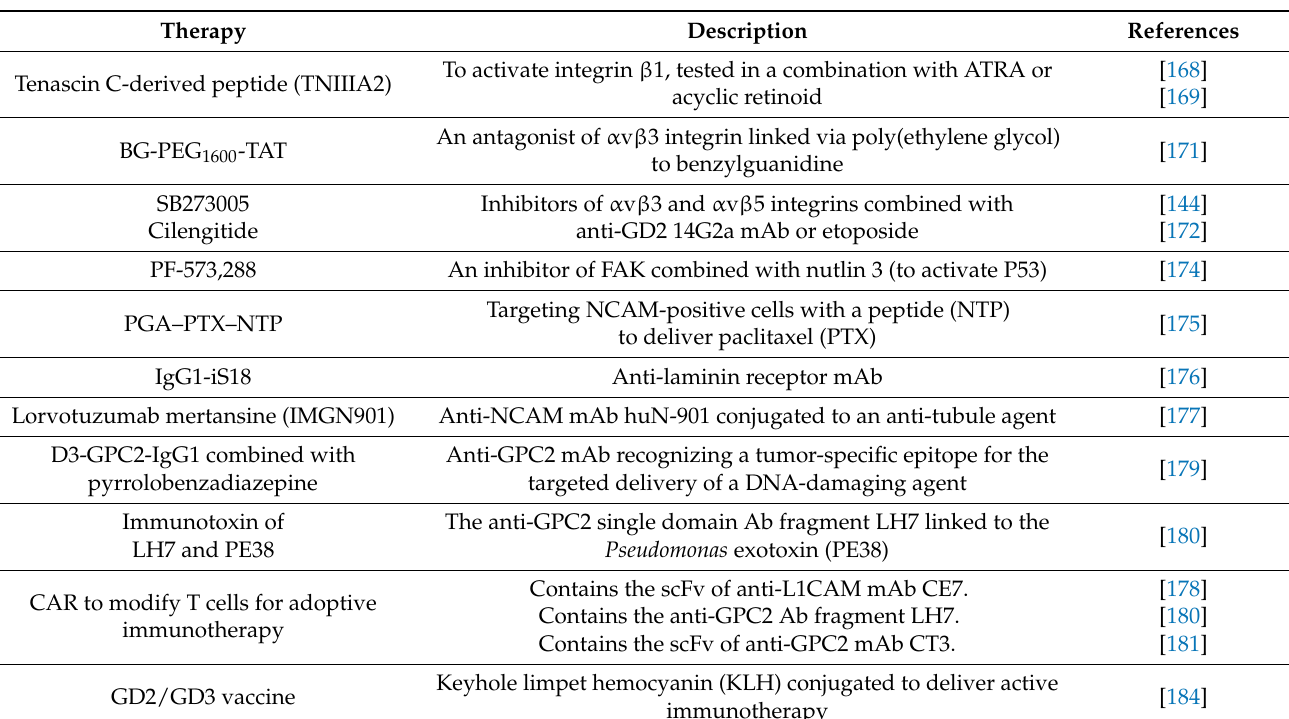
Table 1. Examples of newly developed approaches to target neuroblastoma based on knowledge about interactions of the tumor cells with the TME (see Section 7 for more